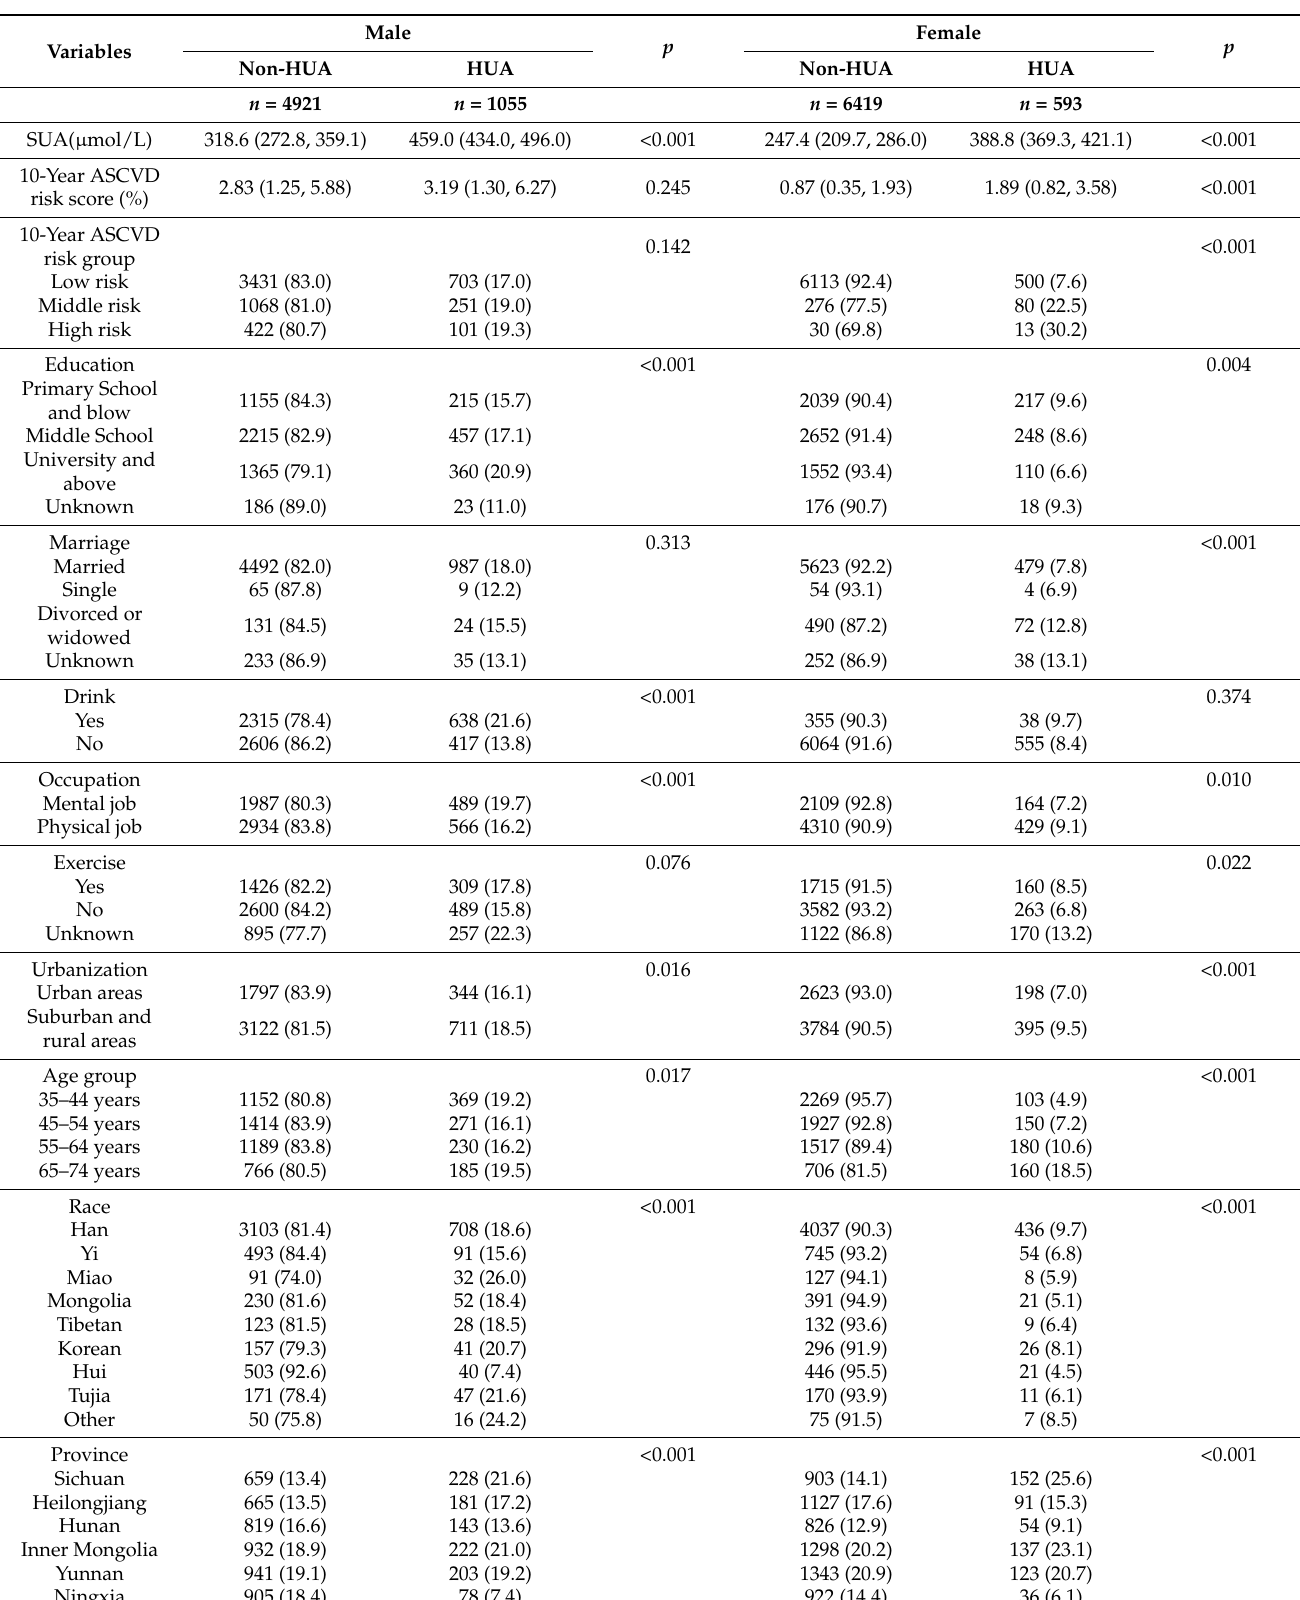
Table 1. Baseline information of participants and prevalence of hyperuricemia by